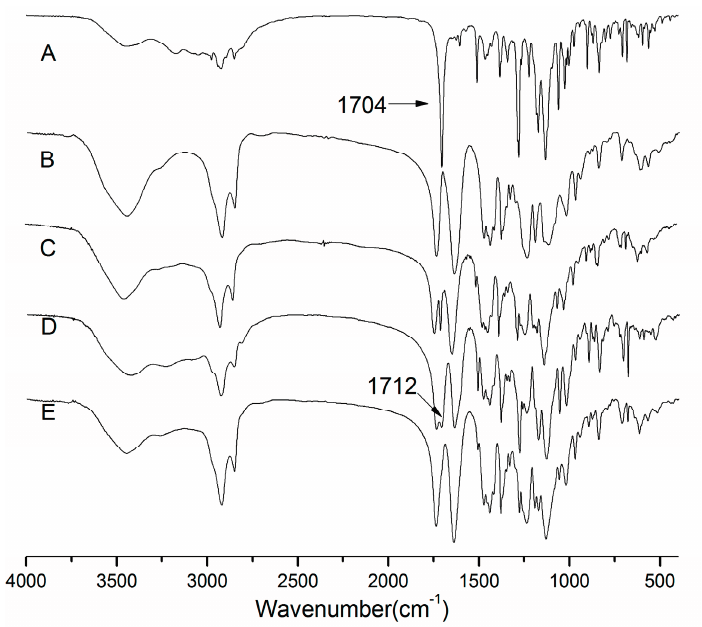
Figure 5. FTIR spectra of Aprepitant ( A ); Soluplus ® ( B ); 1:5 pysical mixtures ( C ); 1:1 SDs ( D ); 1:5 SDs ( E ).